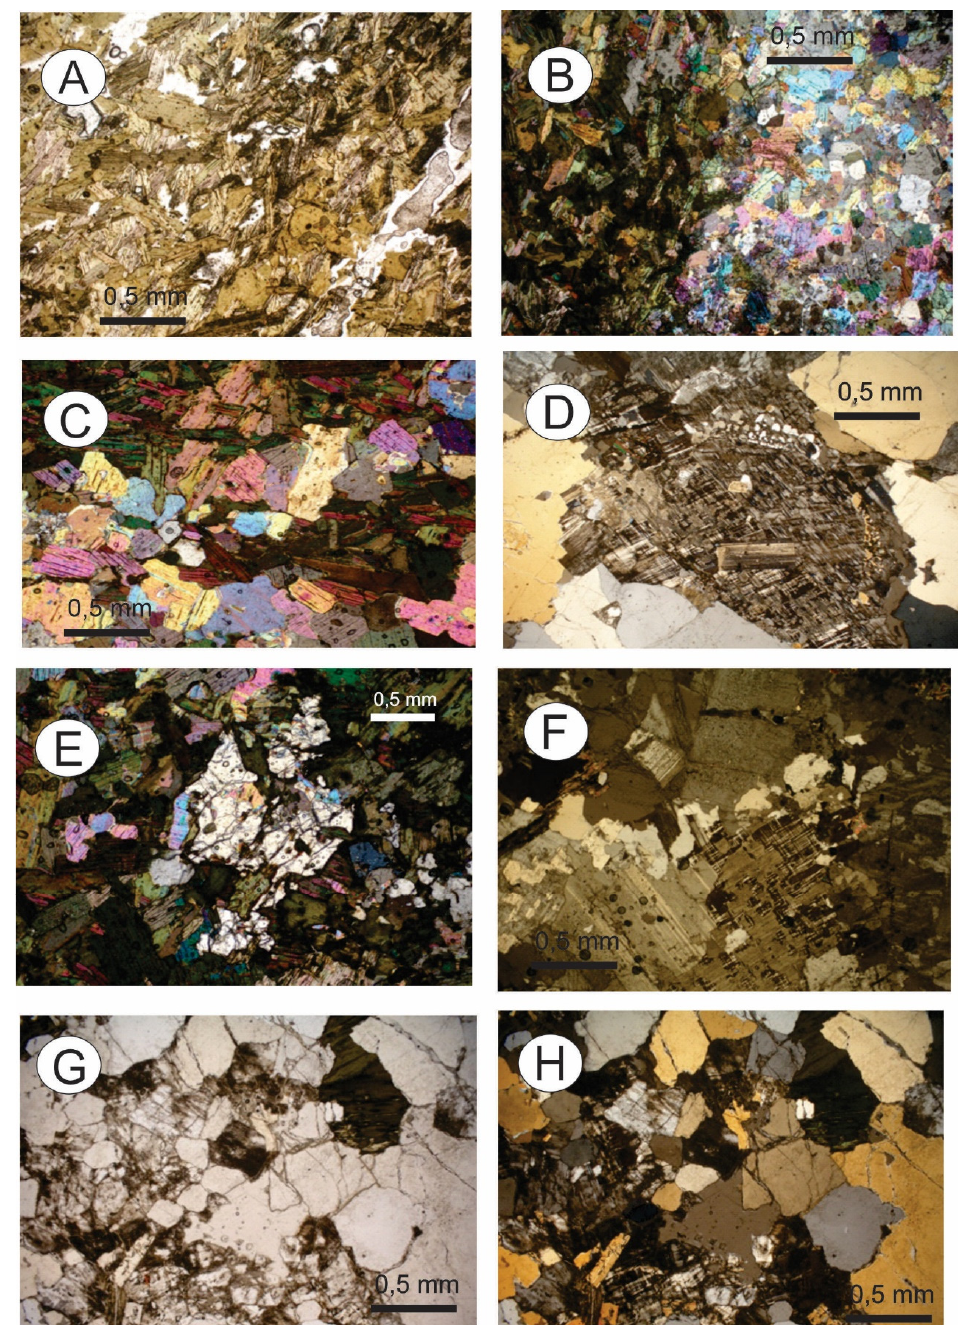
Figure 15. Microscopic appearance of the pegmatites and exogreisens associated with the alkali-granite observed in the São Domingos region; ( A ) Rock composed of quartz-sericite-greisen; ( B ) opaque minerals with sericitic mass bordering quartz crystals; ( C ) Detail of exogreisens minerals showing red coloration at the edges and white center, (interpreted as ilmenite); ( D ) quartz crystals in contact with zinnwaldite, quartz, and cassiterite. ( E ) topaz crystal fractured. among micas. ( F ), rounded quartz grains, green biotite, and interstitial microcline. ( G ) photomicrographs with parallel and ( H ) and crossed nicols: fine quartz, sericite, and cassiterite matrix.